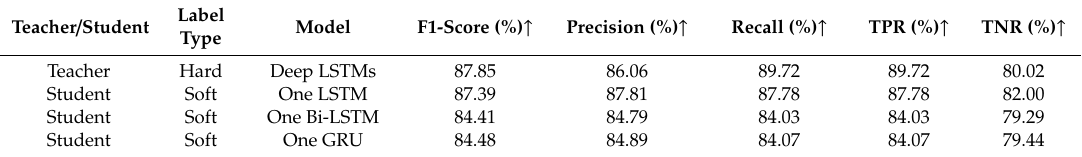
Table 4. Performance comparison of shallow LSTM, Bi-LSTM, and GRU for optimal student model construction of the proposed